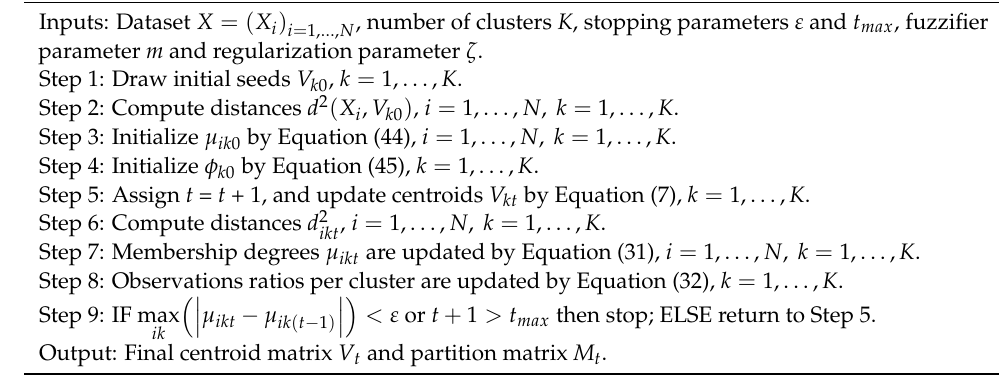
Algorithm 1. Fuzzy C-Means with R é nyi Relative Entropy and Cluster